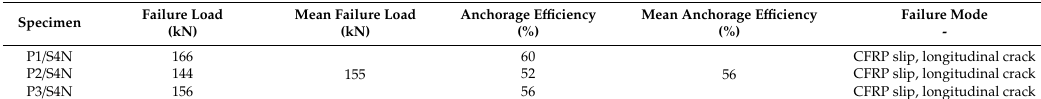
Figure 19. Load-displacement plots for all the specimens in the S4N series. Table 7. Test results of the specimens tested in S4N series.